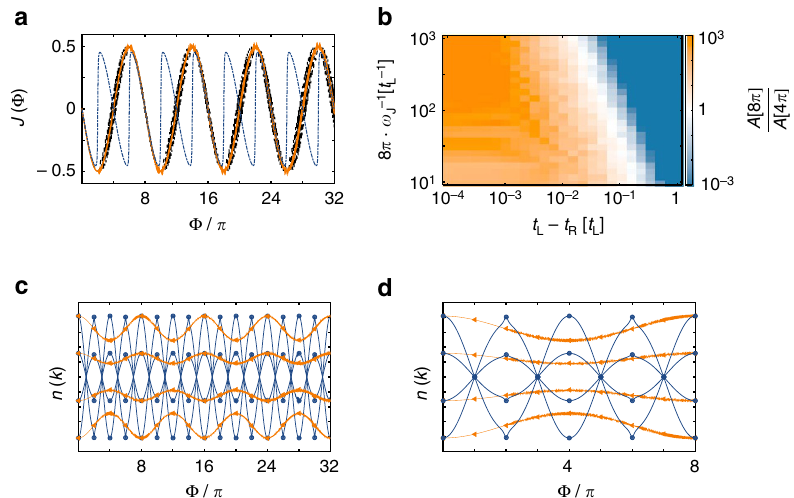
10 3 t (cid:2) 1 t L (cid:2) t R ¼ 10 (cid:2) 4 t L J ¼ L ; 10 3 t (cid:2) 1 t L (cid:2) t R ¼ 10 (cid:2) 1 t L (blue, dash). ( b ) Logarithm of the ratio of the J ¼ L ; 10 3 t (cid:2) 1 and J ¼ L